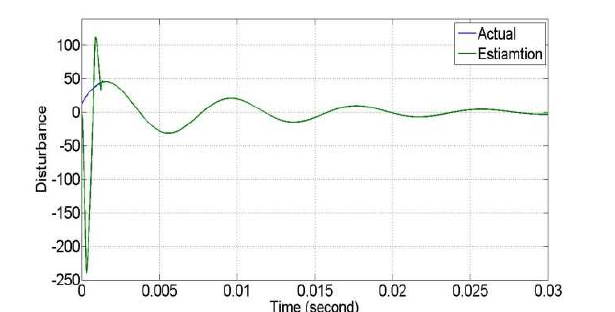
estimation under ¢